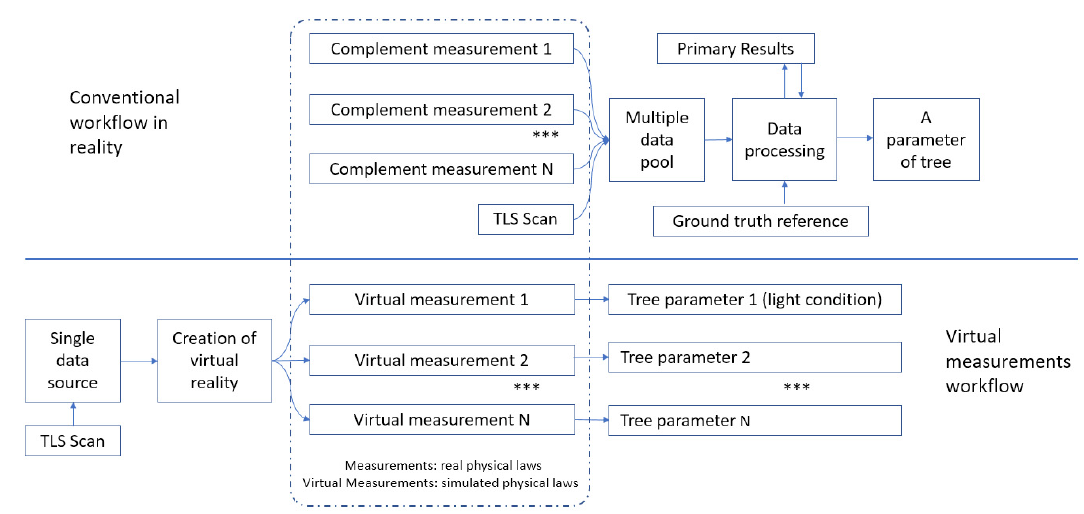
Figure 1. Comparing the differences between conventional studies in reality and VMW in virtual space. The sign *** represents the omitted measurements from 3 to N-1.